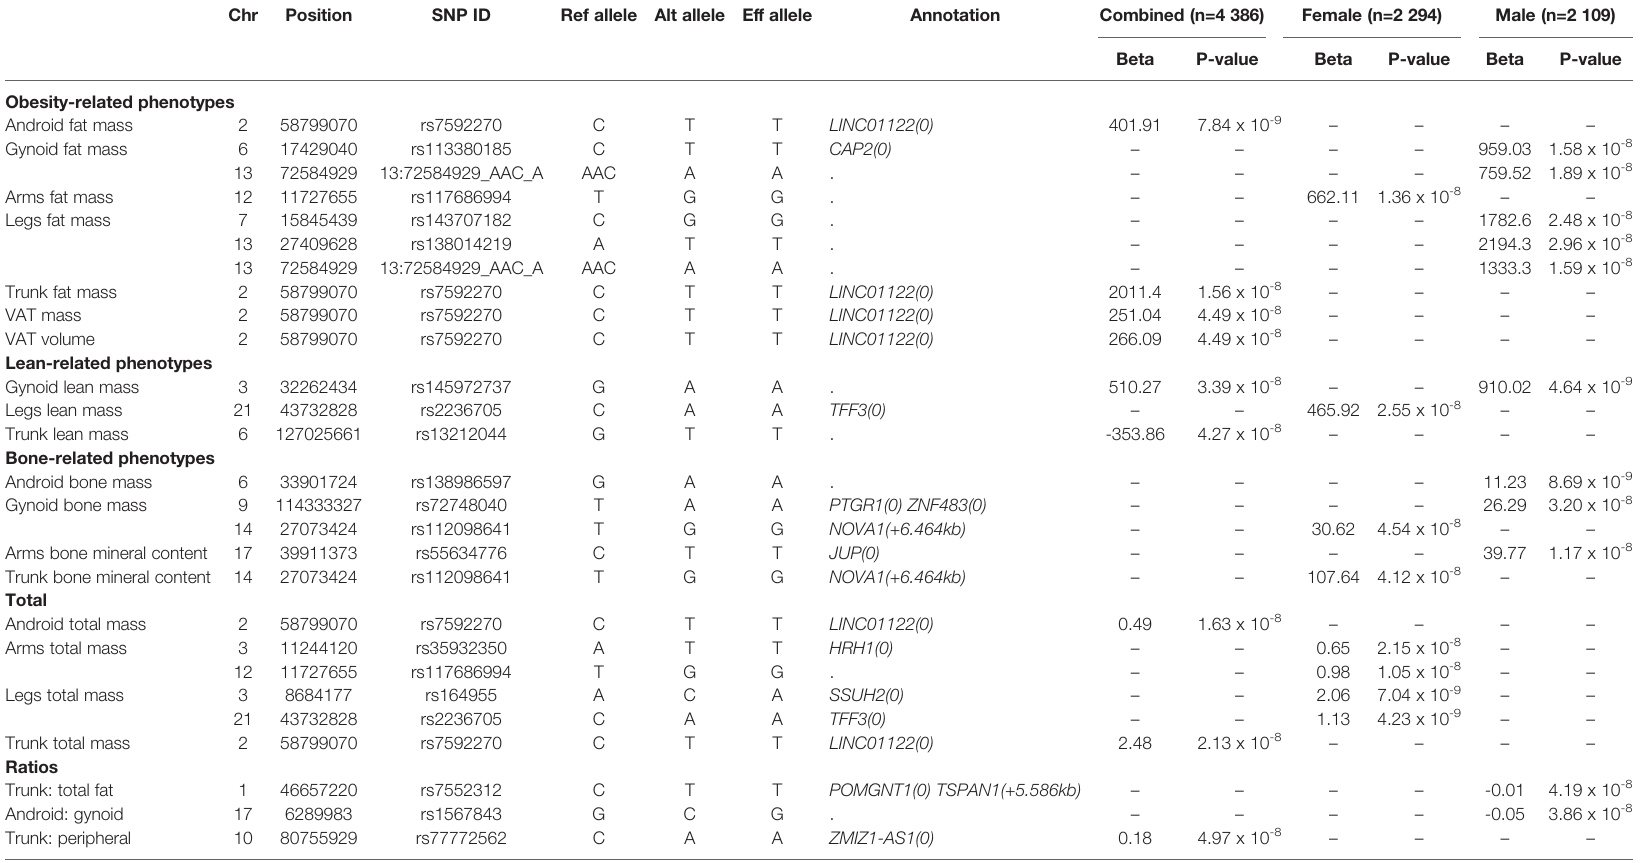
TABLE 2 | List of SNPs in combined, female and male datasets signi fi cant at p< 5.0 x 10 -8